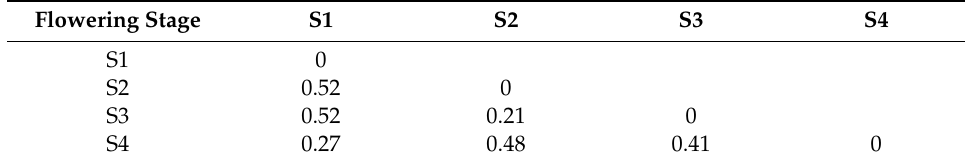
Table 2. The Bray-Curtis dissimilarity index among di ff erent stages of M . ioensis “Prairie Rose” flowers.